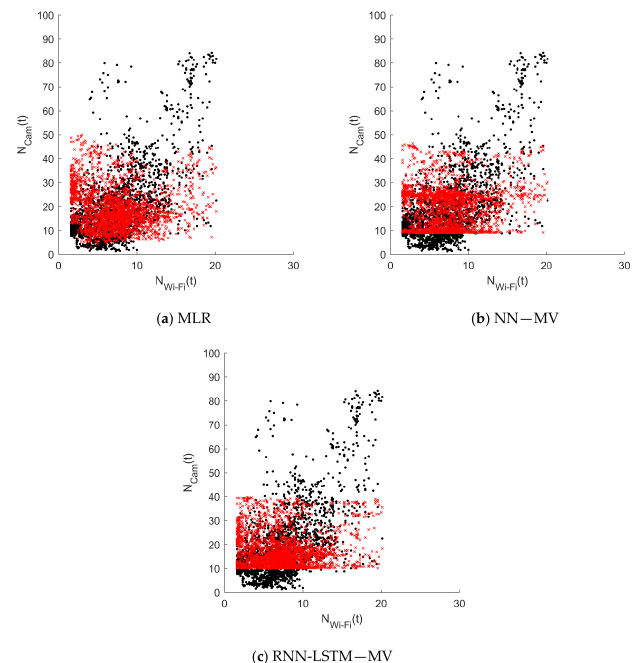
Figure 7. The relation between the ground truth (black dot) and the model estimation (red cross) for both validation days (Thursday & Saturday) and all sensor locations (i.e. C1–C5) for ( a ) model 6: MLN ( b ) model 8: NN—MV, and ( c ) model 9: RNN-LSTM—MV.